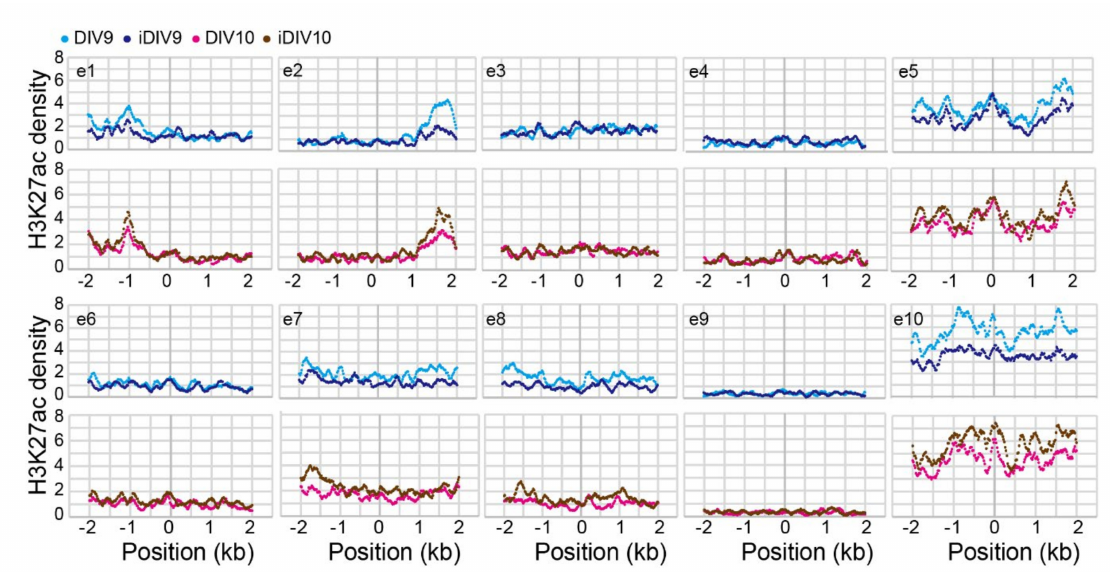
Figure 3. Aggregation of normalized H3K27ac ChIP-seq profiles for candidate WNT3A enhancer sub-regions. Normalized H3K27ac ChIP-seq profiles across the ± 2 kb central base-pair within each candidate enhancer region (e1–e10) for control (DIV9, DIV10) and injured (iDIV9, iDIV10) samples are